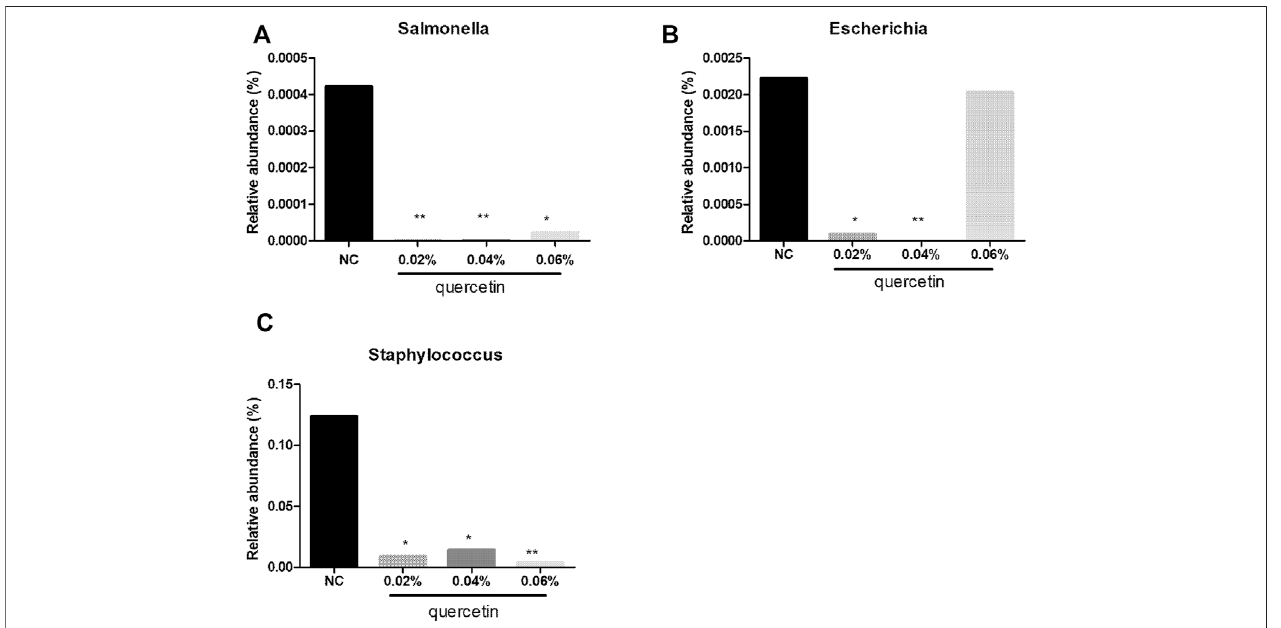
FIGURE2| EffectofquercetinonmicrobialrelativeabundanceintheileumofAAbroilersatthegenuslevel,NC(normalcontrolbroilers)andquercetin(0.02%,0.04, and 0.06%) groups. (A) Effect of quercetin on Salmonella relative abundance in the ileum of AA broilers at the genus level; (B) Effect of quercetin on Escherichia relative abundance in the ileum ofAA broilers at the genus level; (C) Effect of quercetin on Staphylococcus relativeabundance in the ileum of AA broilers at the genus level. Data were statistically analyzed using one-way ANOVA with Duncan ’ s test. Values are expressed as means ± S.D., and n = 1 for all groups. * p < 0.05 and ** p < 0.01.